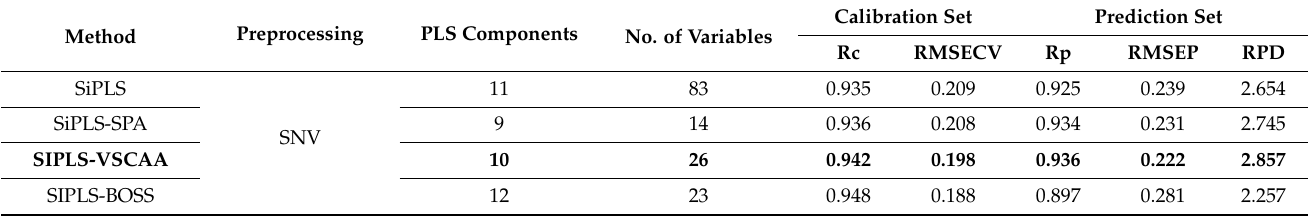
Table 3. PLSR modeling results for SSC based on variables selected by SiPLS, SiPLS-SPA, SiPLS-VSCAA, and SiPLS-BOSS.